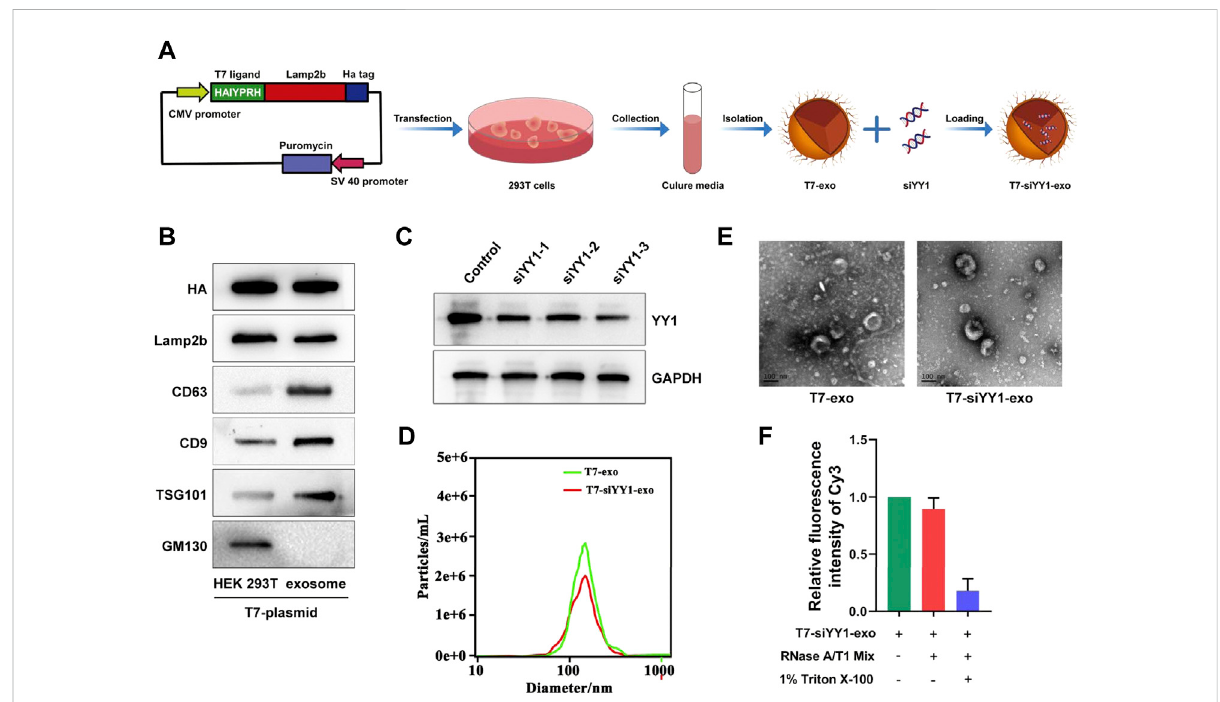
FIGURE 1 Preparation and characterization of T7-siYY1-exo. (A) Schematic diagram of preparation and isolation of T7-siYY1-exo. (B) Detection of CD9, CD63, TSG101, Lamp2b, HA, and GM130 expression by Western blot. (C) Detection of YY1 knockdown ef fi ciency. (D) Size distribution of T7-exo and T7-siYY1-exo measuredbyNANOSIGHT. (E) Transmissionelectron micrograph ofT7-exoandT7-siYY1-exo. (F) qRT-PCRanalysisofsiYY1-Cy3after treatments with RNase A/T1 Mix and 1% Triton X-100 for 30